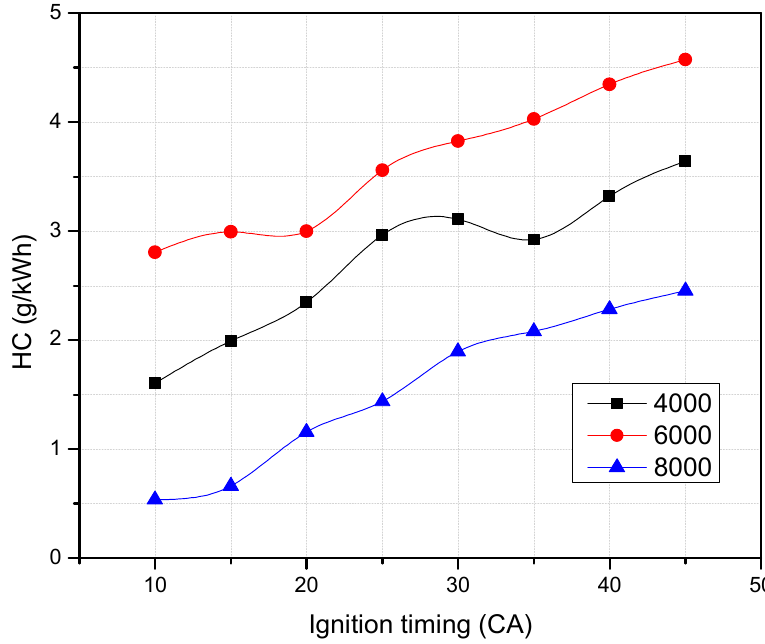
Figure 20. HC emissions versus ignition timing.